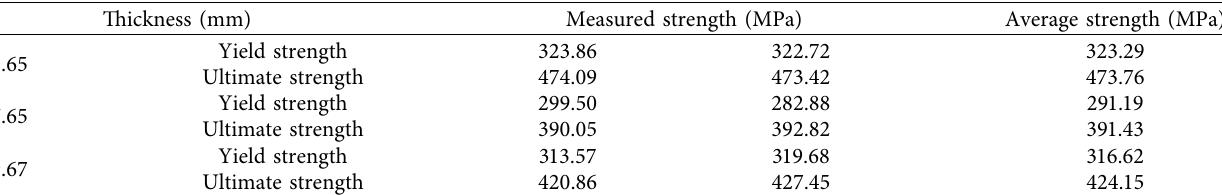
Figure 5: Diagram of the test device. (a) Model diagram and (b) physical diagram. Table 2: Performance parameters of steel.